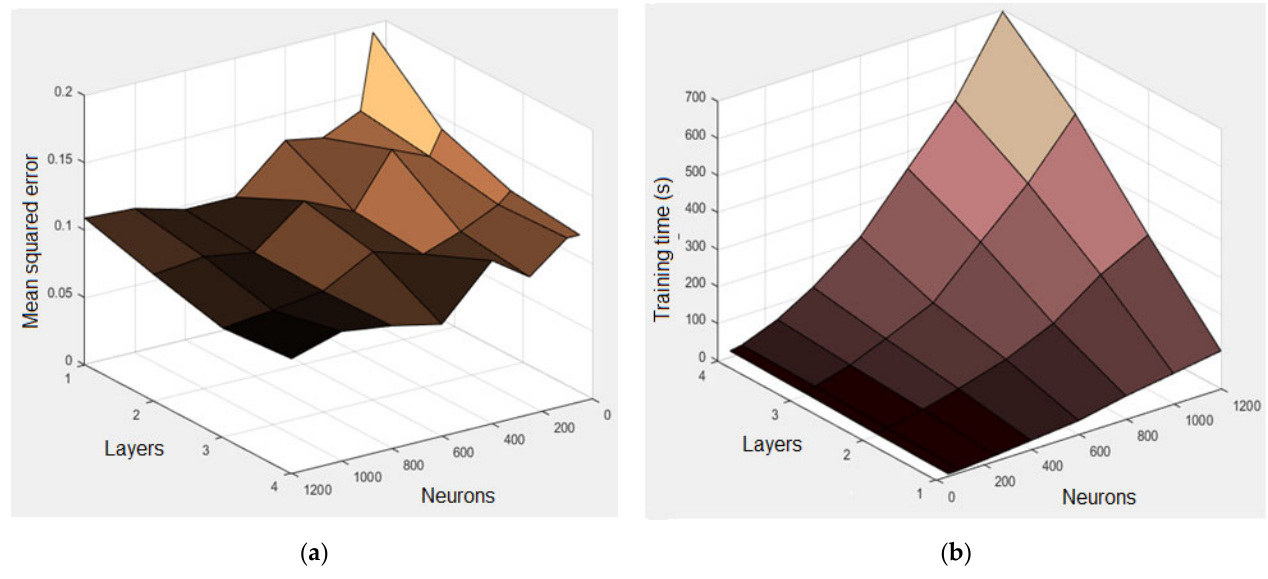
Figure 12. Distribution fields: ( a ) for the mean square error mse of calculating the amount of PM2.5 emissions; ( b ) for the training time of a four-layer neural network.